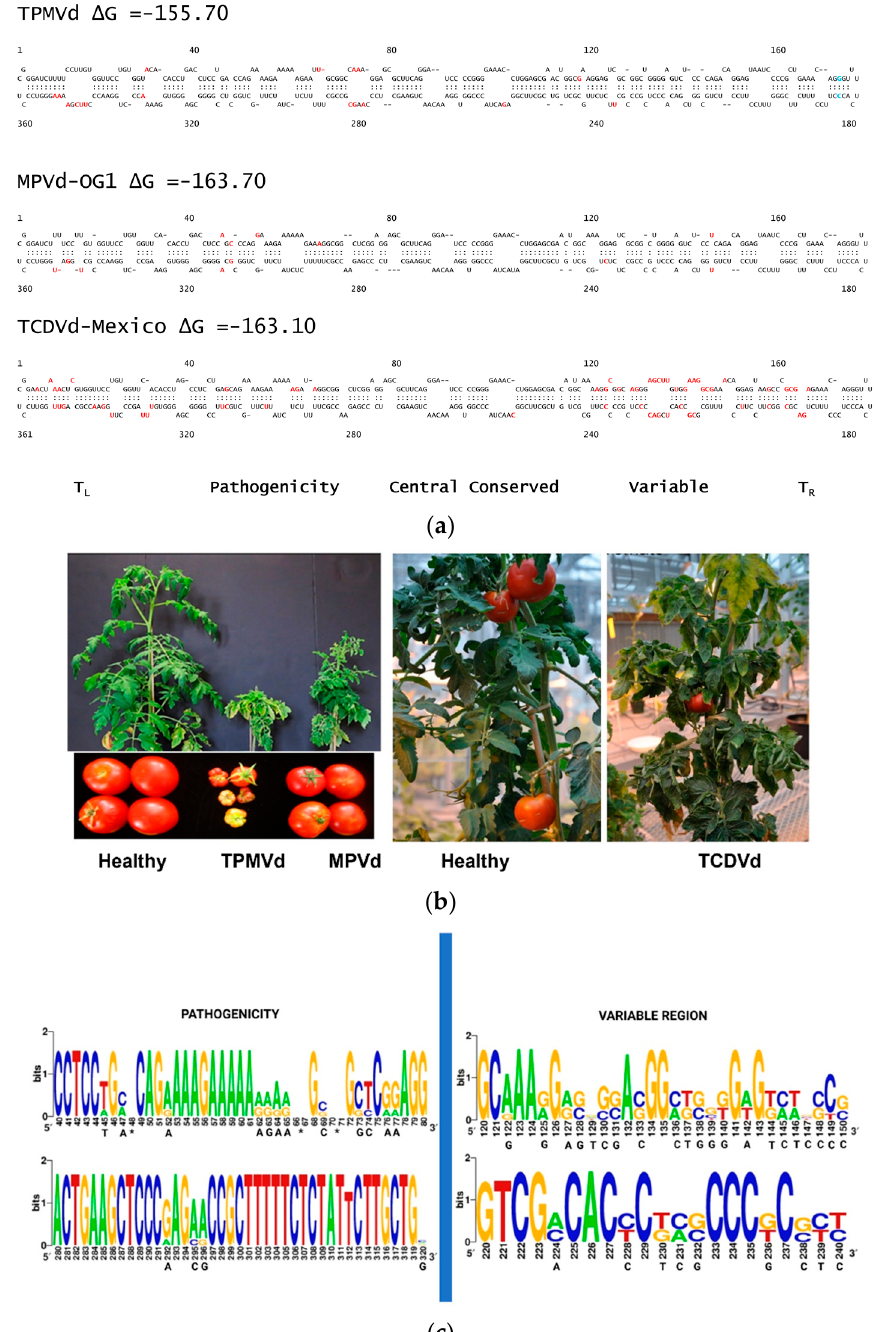
Figure 4. ( a ) Complete nucleotide sequences and secondary structures predicted using the UNAFold Web Server (UNAFold tool available online: www.mfold.org accessed on 15 May 2022) [69] for TPMVd (GenBank K00817), MPVd-OG1 (GenBank L78454), and TCDVd-Mexico (GenBank GQ131572). The nucleotide differences compared to a consensus sequence from alignment of the three viroids are shown in red. The single base pair in the T R domain determining virulence in TPMVd is shown in blue [64]. The putative functional domains are as defined by Keese and Symons [70]; T L = terminal left, T R = terminal right. ( b ) Symptoms of viroid species inoculated onto cv. Rutgers tomato plants 8 wks post-infection. ( c ) Sequence logo depicting the alignments of the Pathogenicity (40–80 nt upper and 280–320 lower strands); and Variable domains (120–150 nt upper and 220–240 lower strands) of the complete genomes of TPMVd, MPVd, and TCDVd-Mexican viroid isolates. Uppercase letters in black color under the number of the nucleotide represent those that correspond to the TPMVd genome.